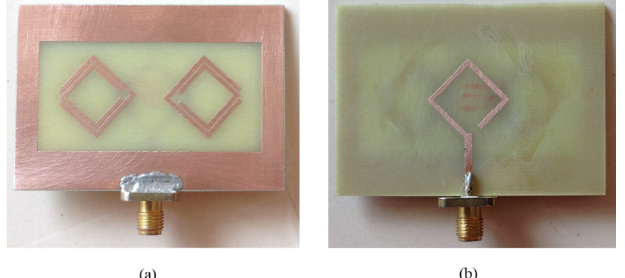
Figure 2: Photograph of the fabricated structure of the proposed slot antenna loaded with rotated square SRR fed by microstrip open loop feed (a) Front view (b) Back